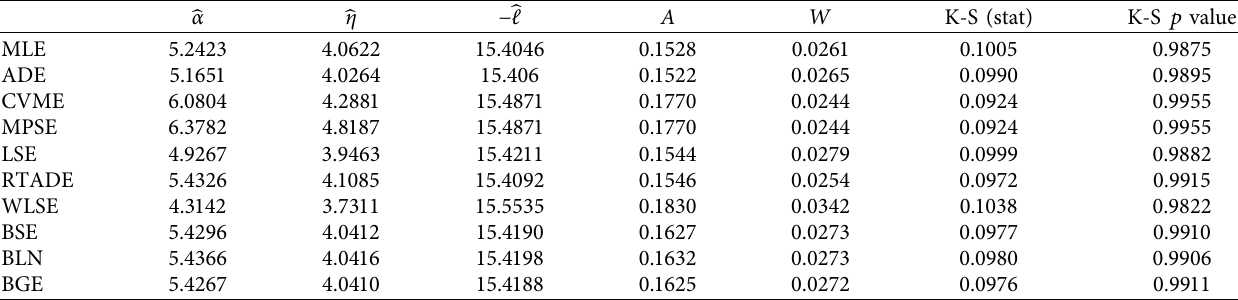
Table 9: The estimates of α , η , − 􏽢 ℓ , A , W , K-S (stat), and K-S p value of the IPBH distribution for dataset II. 􏽢